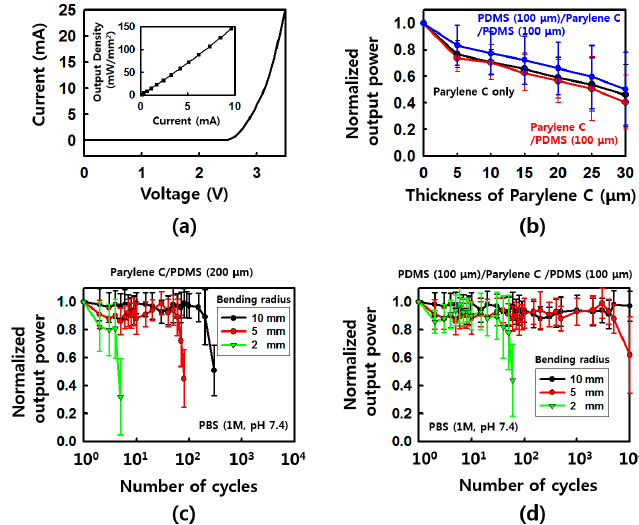
Figure 3. Optical properties of protection layer-coated optoelectronic device. ( a ) Graphs of current and voltage, and current and light output; ( b ) normalized light output power as a function of the thickness of Parylene C with/without polydimethylsiloxane (PDMS) layers; ( c ) normalized output power of Parylene C/PDMS-coated devices as a function of the number of bending cycles with different bending radii; ( d ) normalized output power of PDMS/Parylene C/PDMS-coated devices as a function of the number of bending cycles with different bending radii.